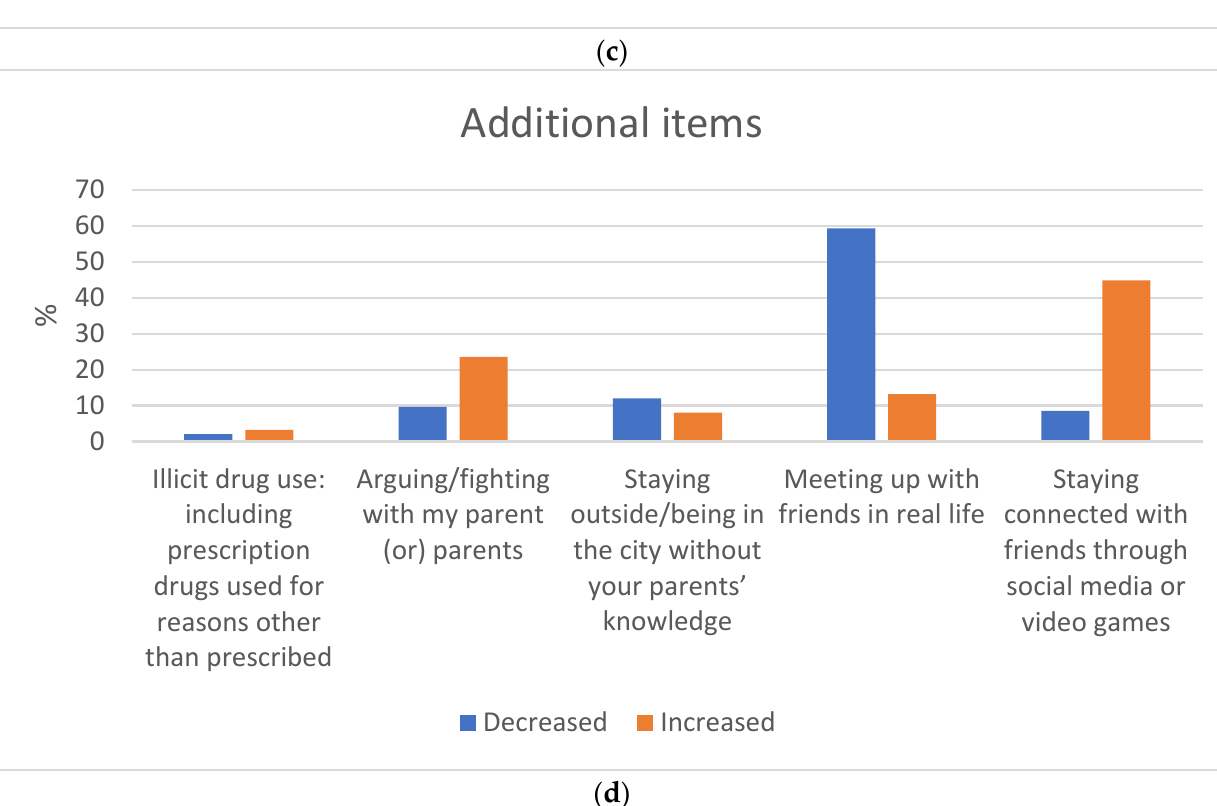
Figure 3. ( a – d ) Changes in adolescents’ risk behavior (Factor 1), Salutogenic approach (Factor 2), Norm-breaking (Factor 3), and Additional item in the multinational study population. ( a ) Changes in risk behavior of adolescents during the COVID-19 restrictions; ( b ) changes in salutogenic approaches of adolescents during the COVID-19 restrictions; ( c ) changes in norm- breaking behaviors of adolescents during the COVID-19 restrictions; ( d ) changes in additional behaviors of adolescents during the COVID-19